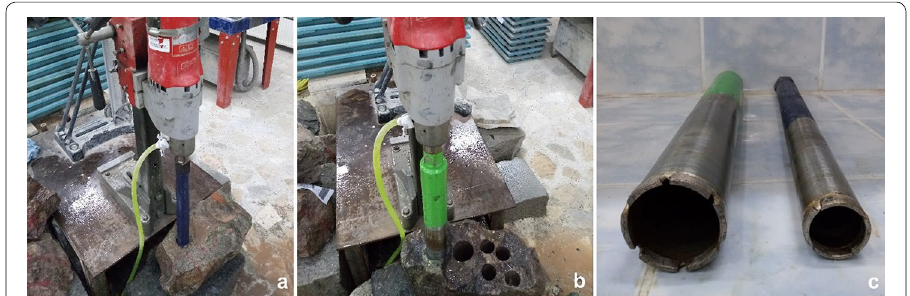
Fig. 1 Coring process by using drill bits with diameters of 32 mm ( a ) and 54 mm ( b ), different size core drillers ( c